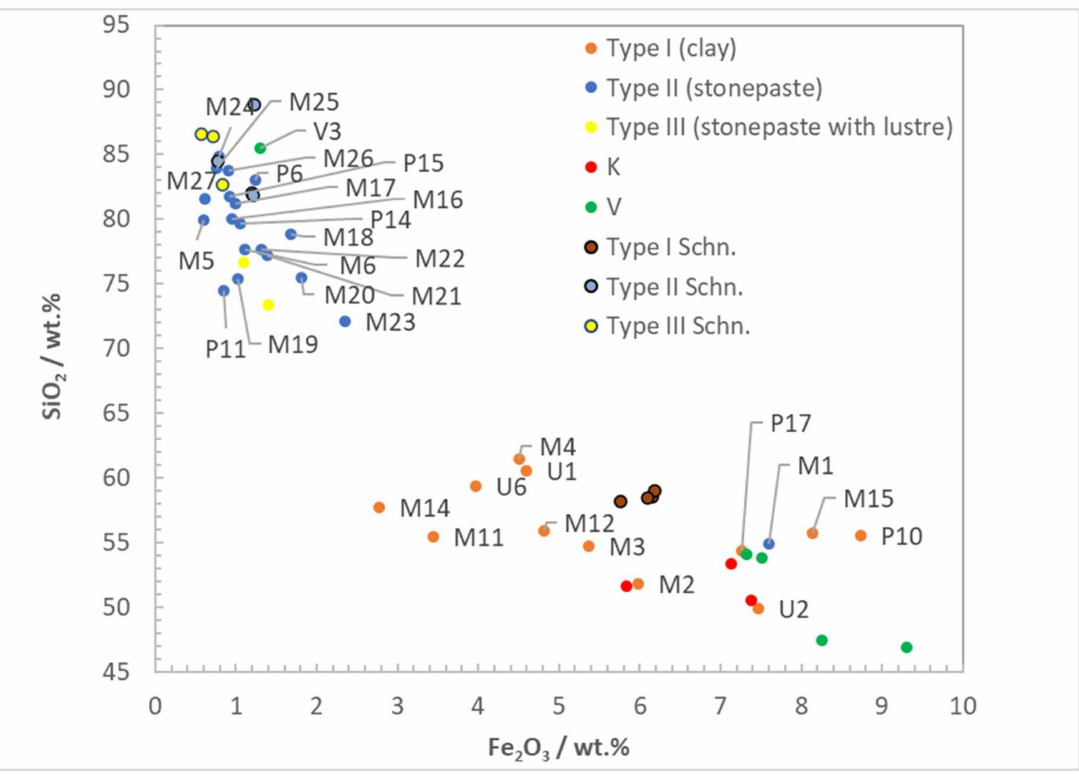
Figure 3. Scatter plot of SiO 2 and Fe 2 O 3 for the ceramic bodies analysed by SEM/EDX. Analyses carried out by Schneider in 1988 are labelled with “Schn.” (Table